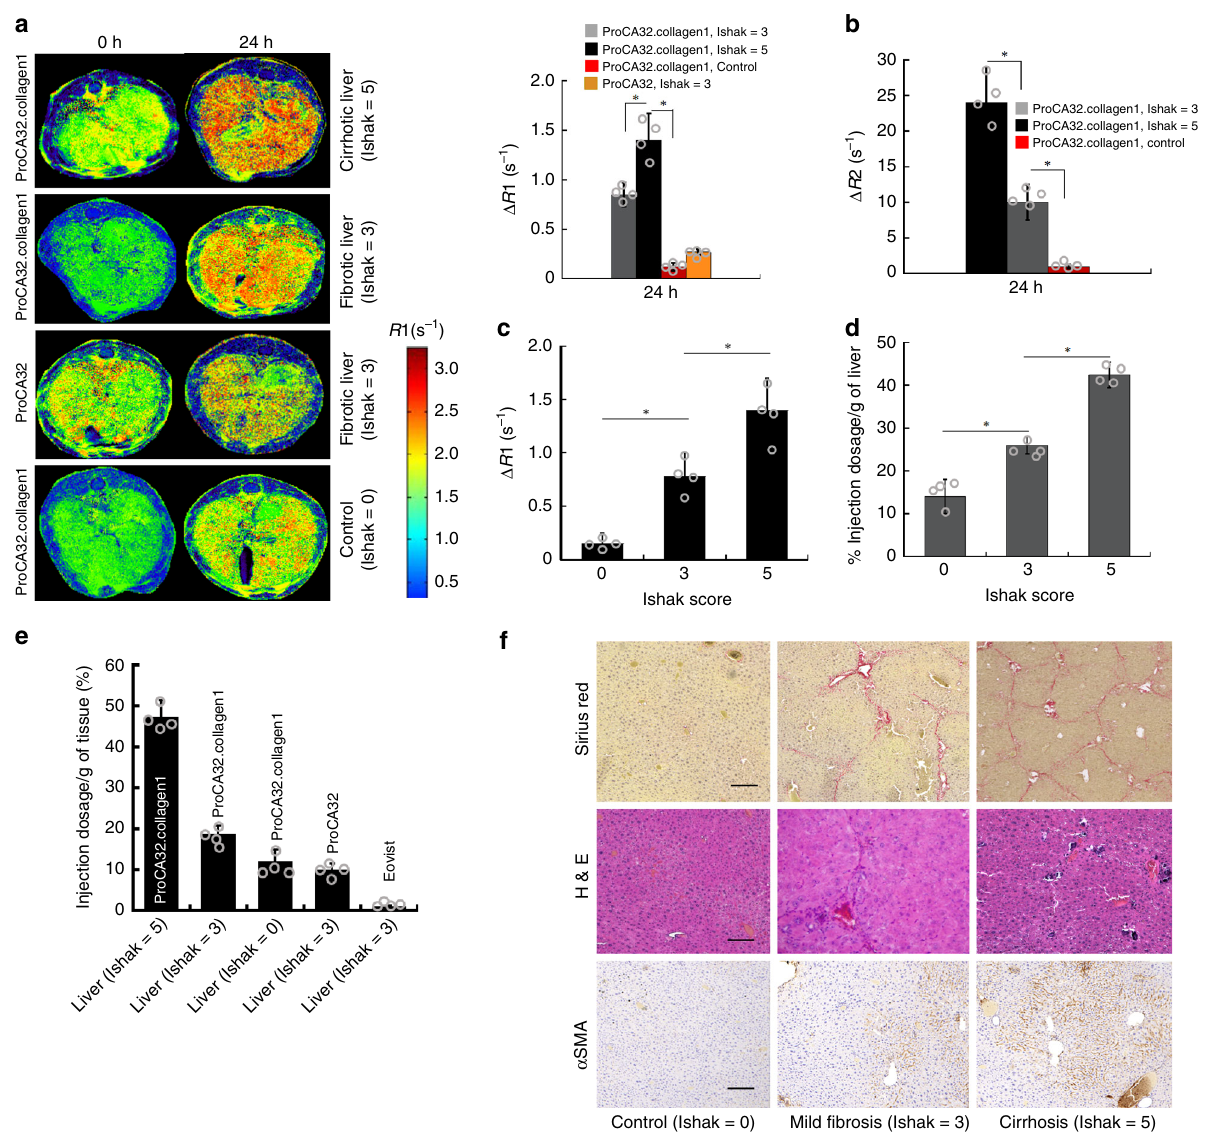
Fig. 2 Early stage detection of liver fi brosis in TAA/Alcohol model. a R1 maps and Δ R1 values of normal (Ishak stage 0 of 6), early-stage (Ishak stage 3 of 6), and late-stage (Ishak stage 5 of 6) liver fi brosis before and 24 h after injection of ProCA32.collagen1, and ProCA32. b Δ R2 values derived from T2 maps demonstrating the highest enhancement for late-stage liver fi brosis at 24 h post injection. c ProCA32.collagen1 can distinguish early-stage liver fi brosis from normal and late-stage fi brotic liver with Δ R1 derived from a R1 map at 24 h time point. d Correlation between Gd 3 + concentration in liver with Ishak score at 24 h time point. e Percent injection dosage of ProCA32.collagen1 based on [Gd 3 + ] in fi brotic and normal livers at 24 h time point. f Sirius red, H&E and α SMA staining of early- and late-stage fi brotic liver compared to normal liver con fi rms the stage of liver fi brosis. scale bar, 100 µ m, * P < 0.05, student ’ s t test, all data are represented as mean ± SD, n = 4 biologically independent animals in each